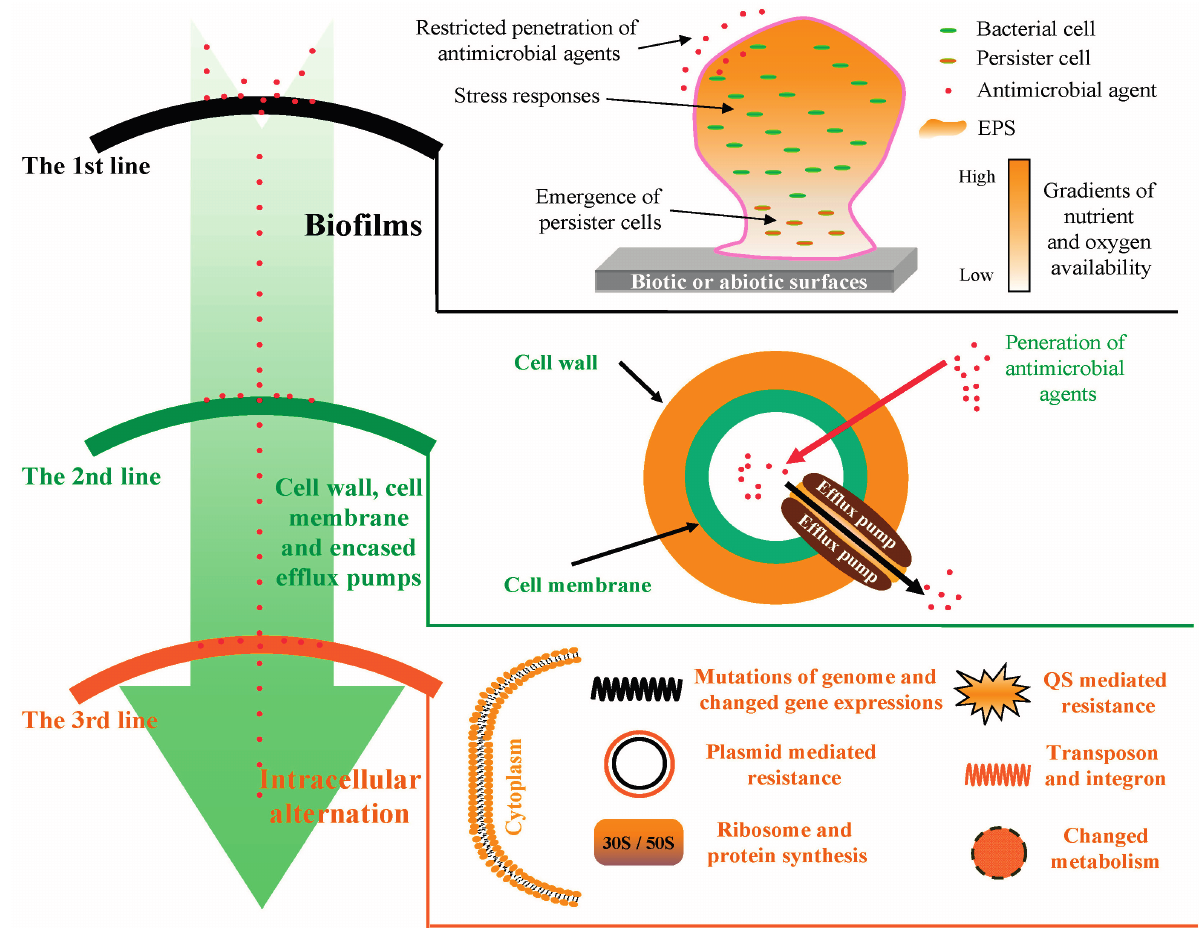
Figure 1. Simplified diagram summarizing the mechanisms of the three defense lines of resistance to antimicrobial agents for bacteria. There are three lines of defense for bacterial cells to overcome death by antimicrobial agents. The first defense line is bacterial biofilms, which limits the penetration of antimicrobial agents. The cell wall, cell membrane and the encased efflux pumps construct the second defense line to limit the absorbance or elevate the excretion of antimicrobial agents. When antimicrobial agents enter the bacterial cells, they meet the third line of defense, involving the alteration of target sites, regulation of gene expression and production of certain